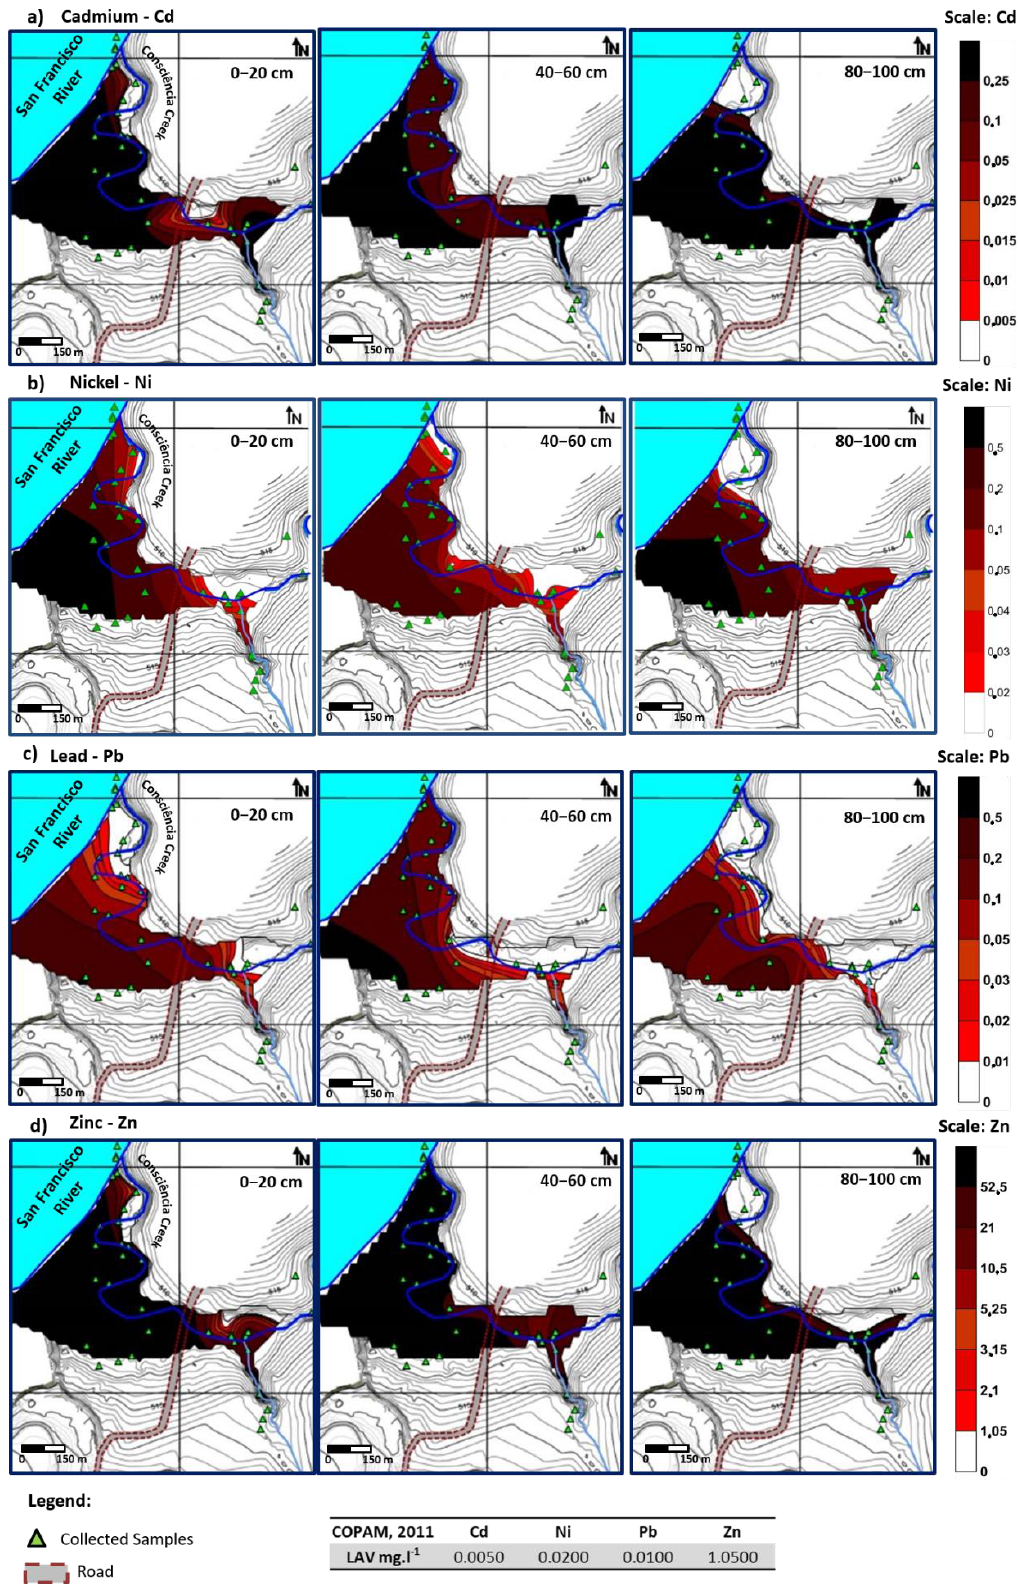
Figure 4. Spatial distribution maps of the most relevant elements at different depths (0–20, 40–60, and 80–100 cm); The sections ( a ), ( b ), ( c ) and ( d ) refer to Cd, Ni, Pb and Zn respectively. Scales in accordance with the legally admissible values (LAV) for groundwater [22].